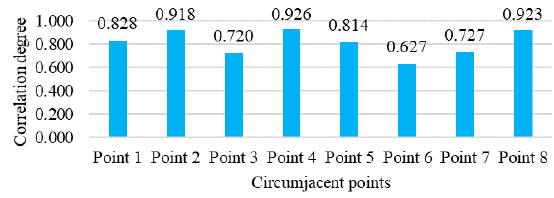
Figure 6. Correlation degrees of di ff erent circumjacent points with the blind